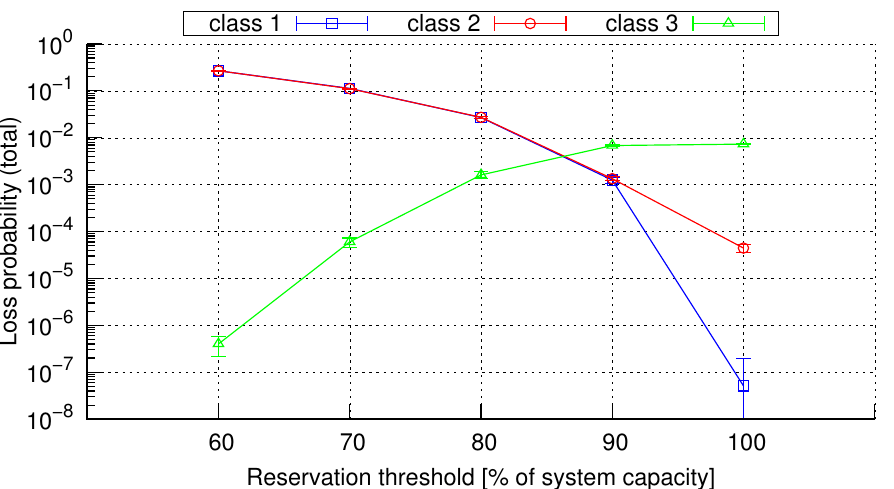
Figure 15. Changes in the loss probability for calls of individual traffic classes in System 1 in relation to the value of reservation threshold. The results are presented for the value a = 0.7 Erl of traffic offered to a single FSU.